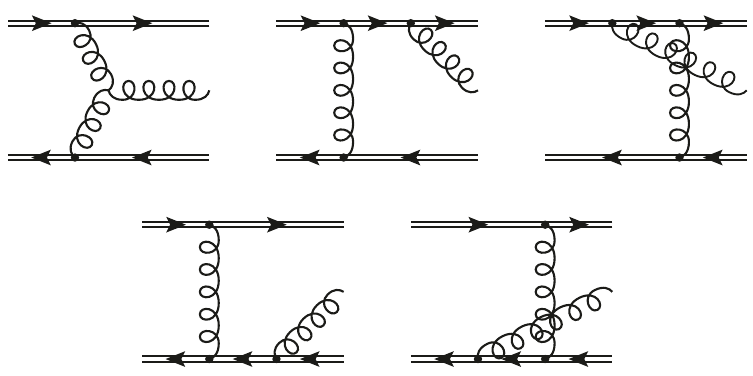
Figure 2 . Feynman diagrams contributing to the gauge-invariant tree-level scattering amplitude of g (cid:3) + g (cid:3) g in the Wilson lines formalism (see appendix A). The (cid:12)rst diagram represents the ! standard QCD contribution; the other four have to be added in order to restore gauge